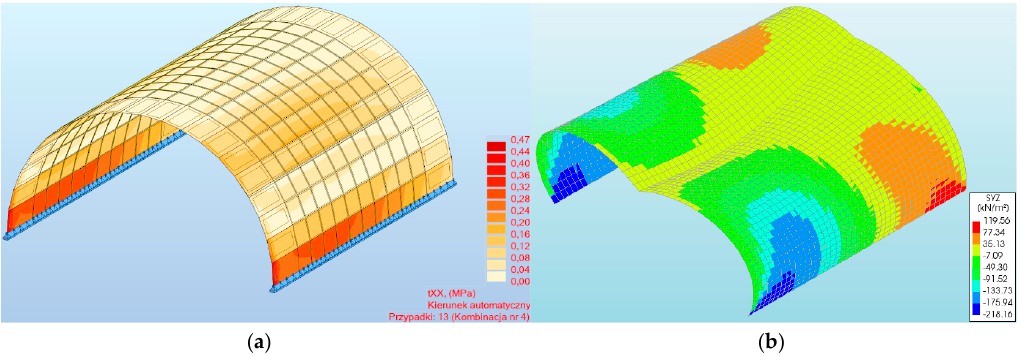
Figure 11. Maximum normal stresses of a three-hinged arch obtained in the program: ( a ) #1, ( b ) #2.